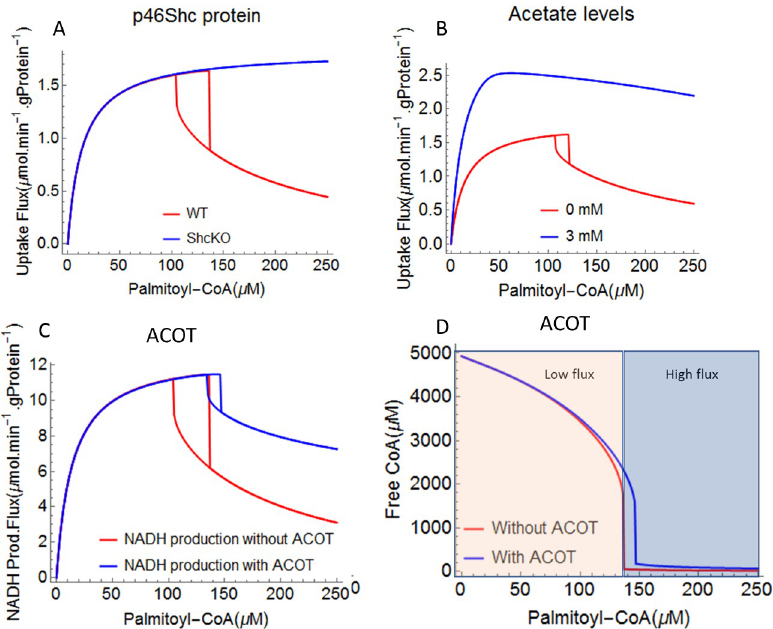
Fig 7. Model extensions and mFAO bistability. The computational model was extended with the different reactions indicated in Fig 1 and detailed in S1 Text. A. Activation of MCKAT via reducing the inhibitory effect of p46Shc protein (WT: wild type and ShcKO: 20% residual activity of p46Shc protein. B.The model was extended with PDH and ETC and activation of CPT1 and ETC by SCFA. C and D. The model was extended with